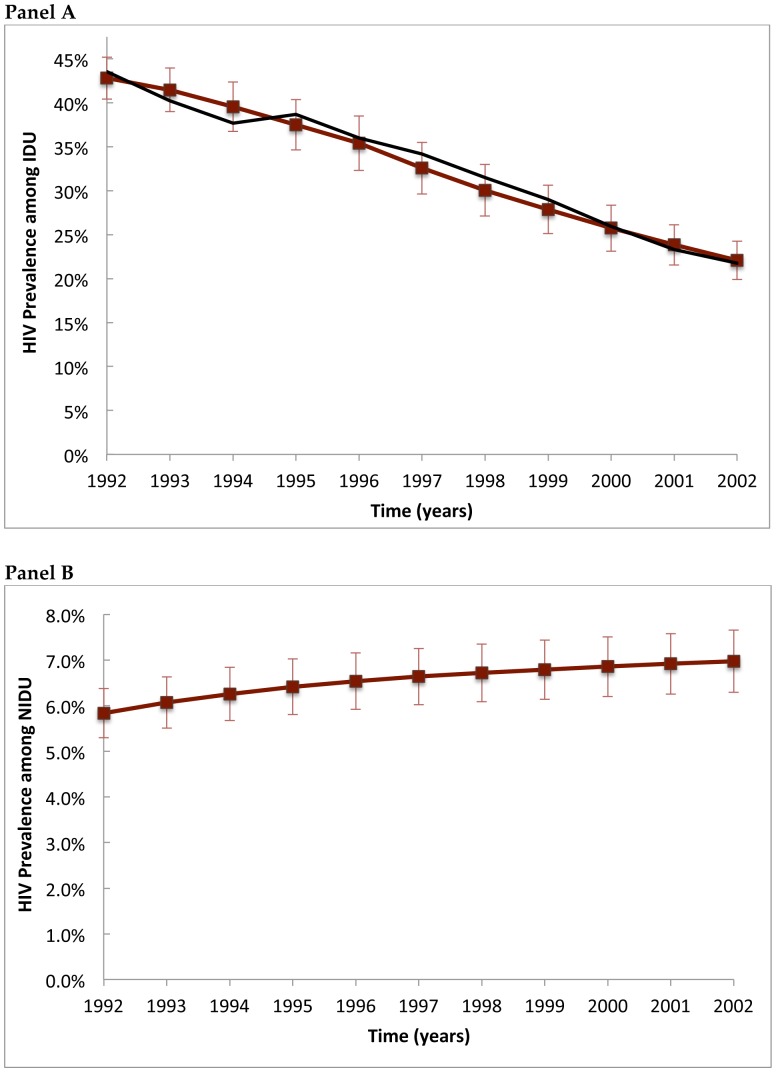
HIV prevalence among IDU (panel A) and NIDU (panel B) obtained from a Monte Carlo simulation of the agent-based model.Black lines indicate empirical trajectories [70]. Error bars represent two standard deviations of the bootstrap estimates; CVAR data for HIV prevalence among NIDU is not available.